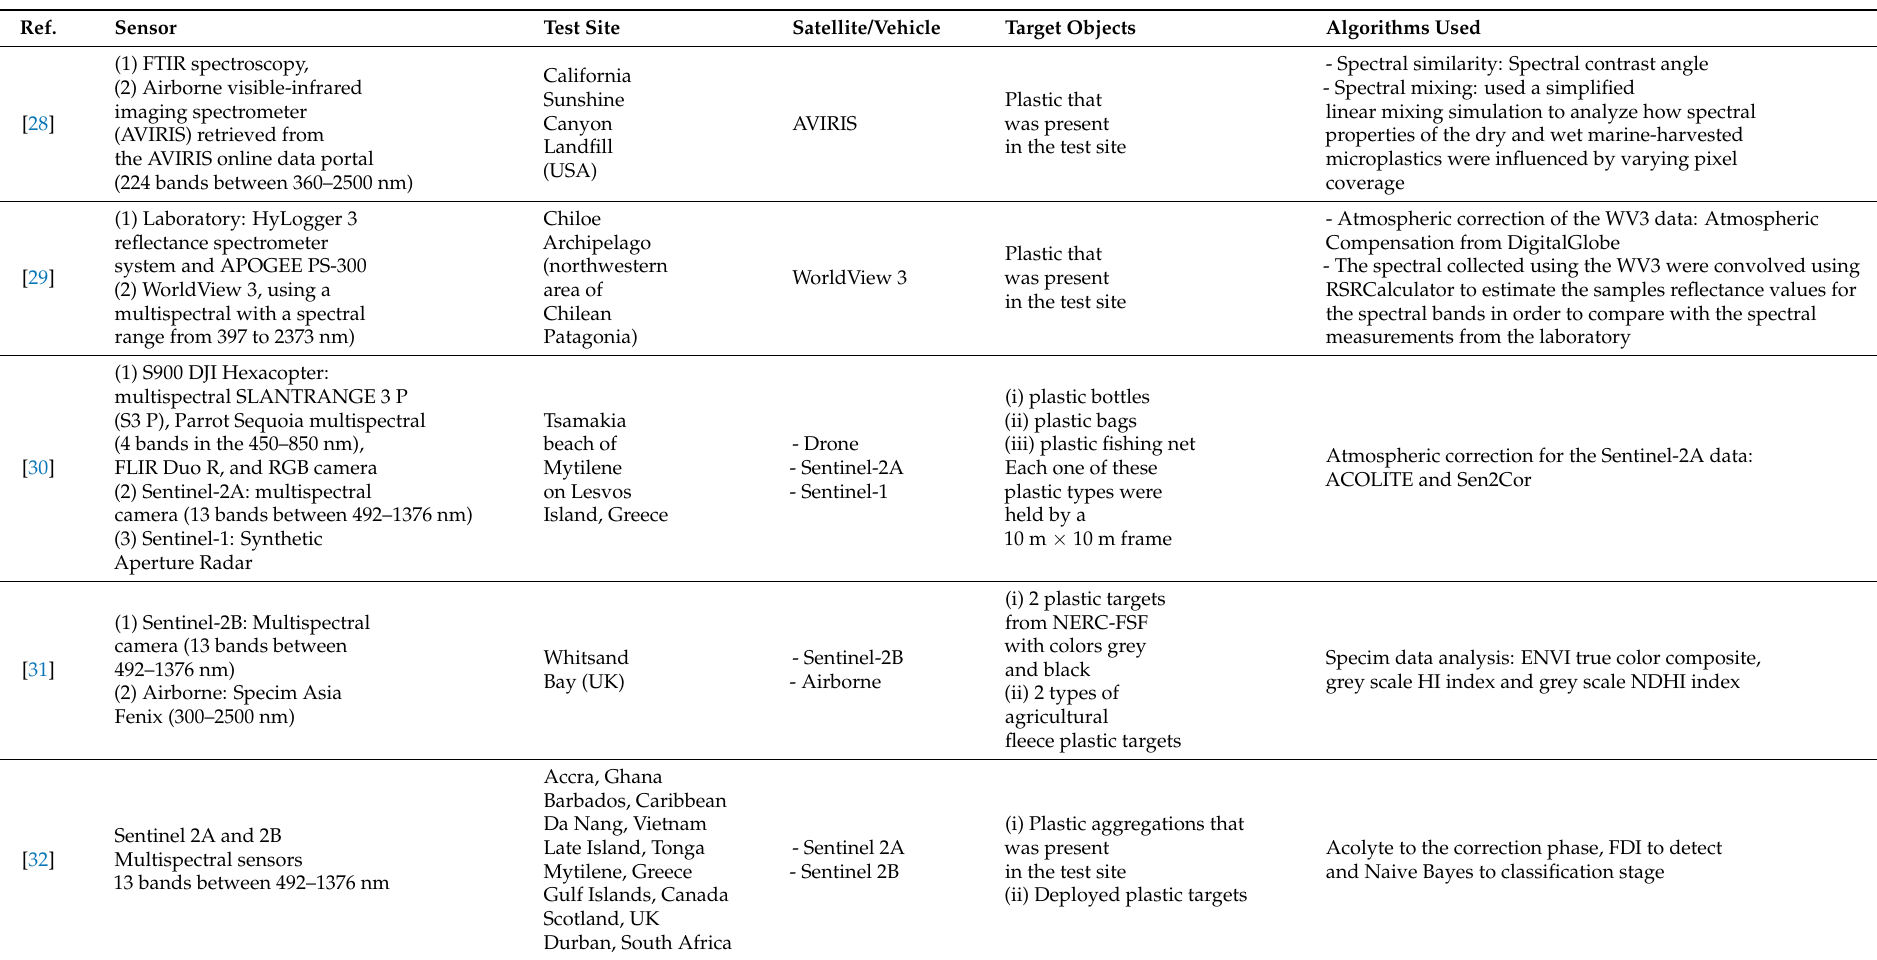
Table 1. Marine litter detection